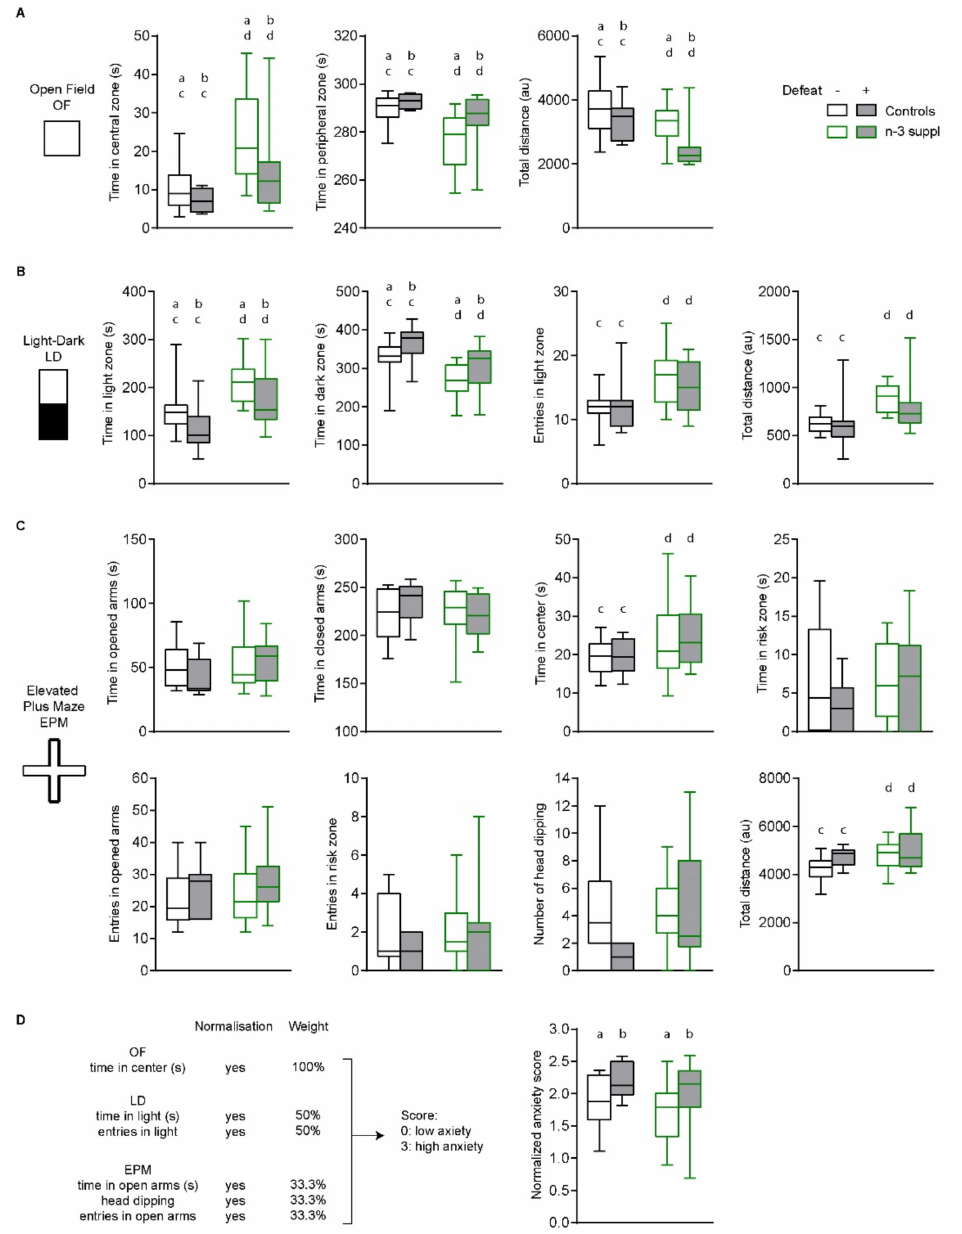
Figure 4. n-3 supplementation has anxiolytic effects. n-3 supplementation induces anxiolytic-like effects in the open field (OF) ( A ) and the light–dark (LD) tests ( B ) but has only minimal effects on the elevated plus maze (EPM) test ( C ). ( D ) Anxiety scores were calculated by normalizing and balancing 6 different behavior measurements. Two-way ANOVAs were performed, with ‘stress’ and ‘diet’ as factors. Statistically significant results are reported as follows: [stress] a vs. b, [diet] c vs. d. Please refer to Supplemental Table S1 for further details. Values (box and whiskers plots) are plotted from minimum to